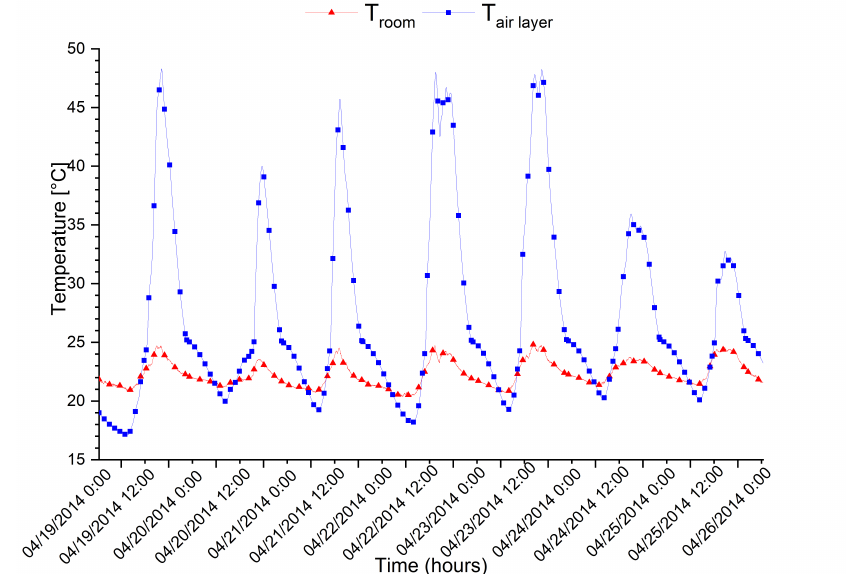
Figure 13. Evolution in the average air temperature inside the ventilated air layer (T air layer ) compared to the room-temperature fluctuation (T room